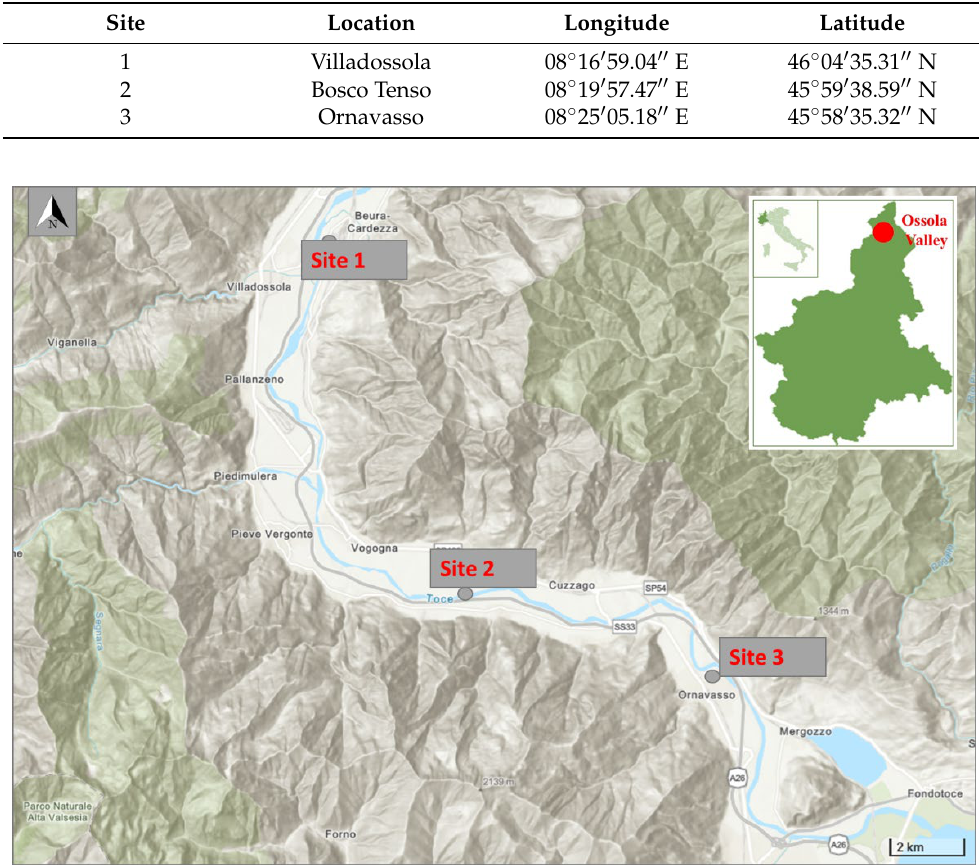
Figure 1. Study area and sites of the biofilm sampled in the Toce River (Ossola Valley).